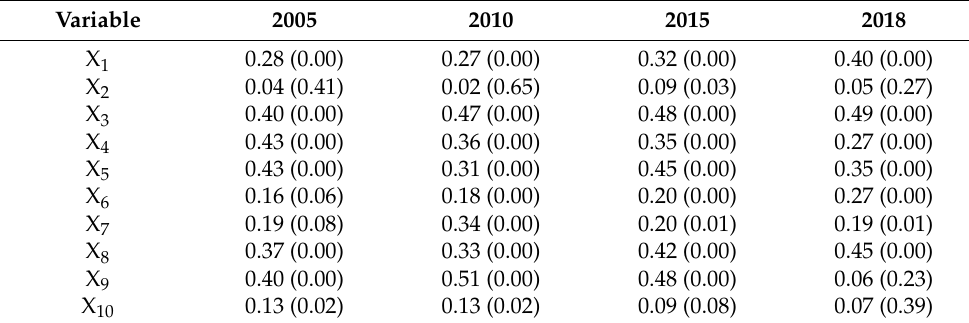
Table 4. Single-factor detection results of CLE in